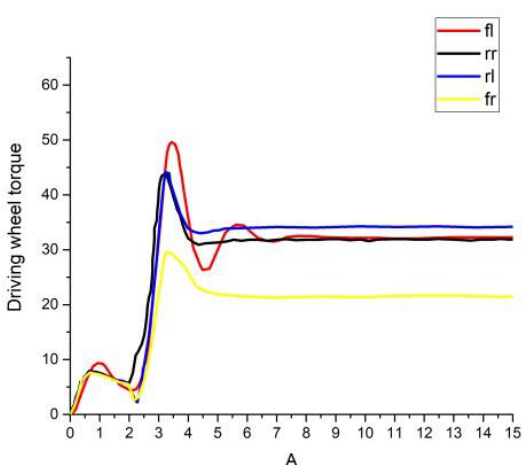
Figure 16. Yaw rate.